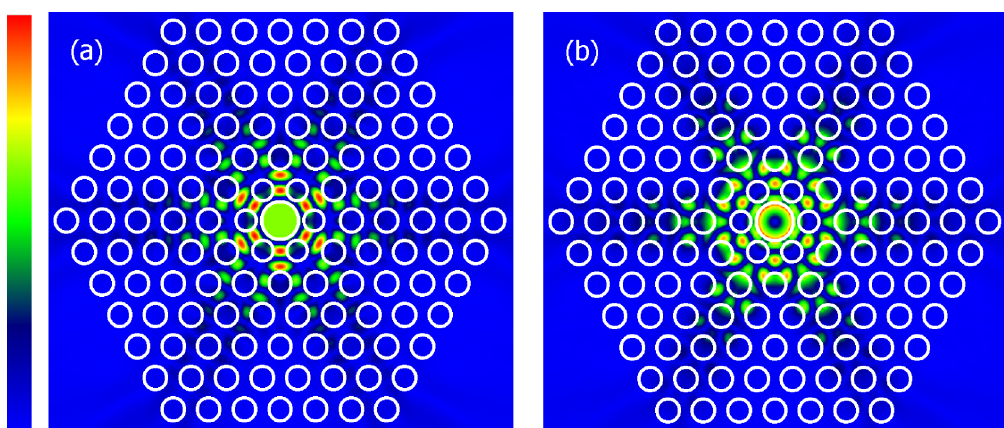
FIG. 12. (a) Longitudinal and (b) radial electric field intensities calculated with the multipole method for the TM defect mode of the 4 : 9 (cid:3) m -period